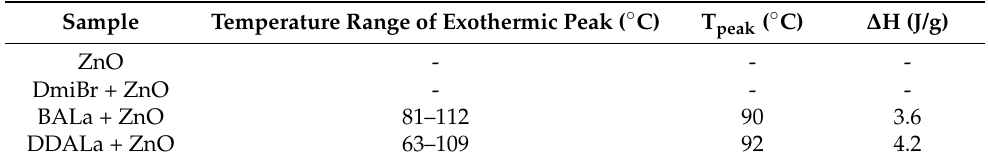
Figure 3. DSC curves for pure zinc oxide (ZnO) and its mixture with ILs. Table 4. DSC analysis for pure ZnO and its mixtures with ILs.